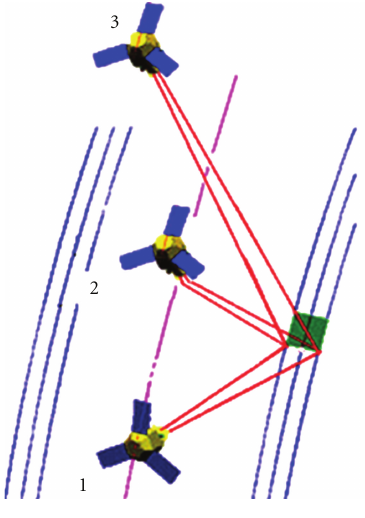
Figure 8: Stereoimaging